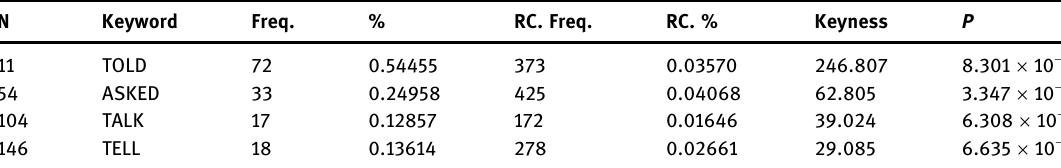
Table 27: Verbalization processes in the keyword